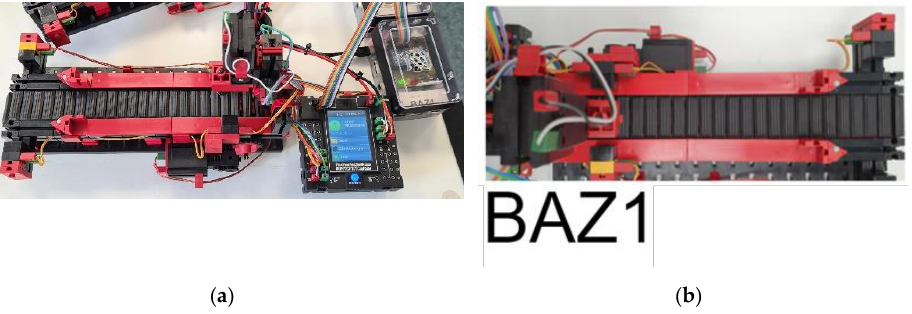
Figure 5. 2D visualisation of Learning Factory 4.0 with a suitable image: ( a ) Workstation 1 (BAZ1) in reality; ( b ) Workstation 1 (BAZ1) in the visualisation of the simulation model.